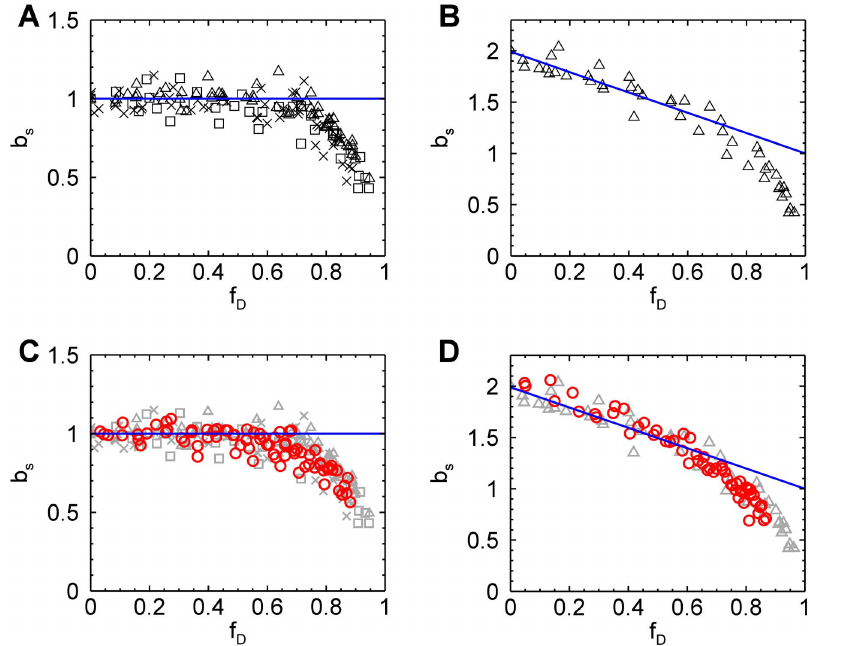
Figure 6. Segmented brightness of EGFP and EGFP 2 in mammalian and yeast cells versus photodepletion fraction. Photobleaching of mammalian cells was accomplished by one-photon excitation, while yeast cells were photobleached by two-photon excitation. (A) The normalized brightness of EGFP in mammalian cells (five COS cells (triangles), five CV-1 cells (squares), six MRC5 cells (crosses)) is close to the theoretical value (blue line) until the photodepletion fraction exceeds 0.6, at which point it begins to drop. (B) The normalized brightness of EGFP 2 in mammalian cells agrees with theory (blue line) until the photodepletion fraction reaches 0.6. (C) The normalized brightness of EGFP from three yeast cells (red circles) shows the same behavior as seen in mammalian cells (grayed symbols, same as shown in panel A). (D) The normalized brightness of EGFP 2 from two yeast cells (red circles) close follows the brightness observed in mammalian cells (grayed symbols, same as shown in panel B).